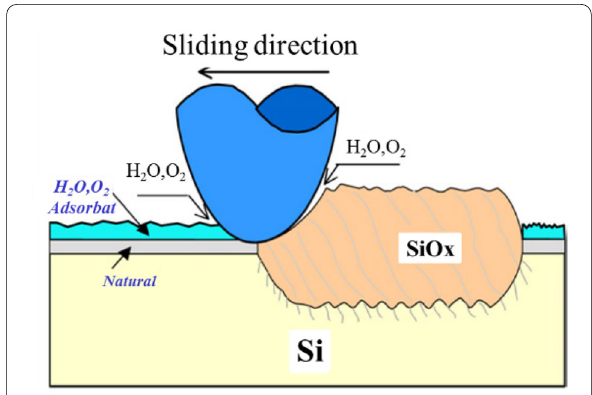
Figure 6 Oxidation-dominated generation of protuberances on silicon surface speculated by Miyake et al. [52]